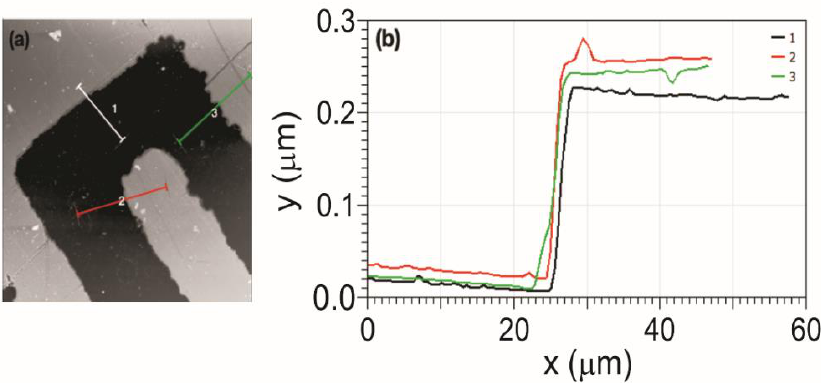
Figure 6. Cross-section analysis of the gold layer deposited on the quartz substrate. ( a ) Three regions have been selected, and their respective cross sections are shown in figure ( b ). The step height values are 225.4 nm (Region 1), 236.8 nm (Region 2), and 235.2 nm (Region 3).